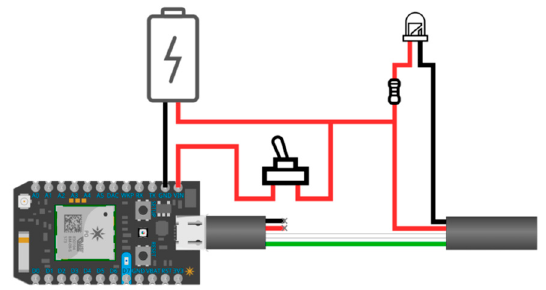
Figure 3. The circuit for battery charging.